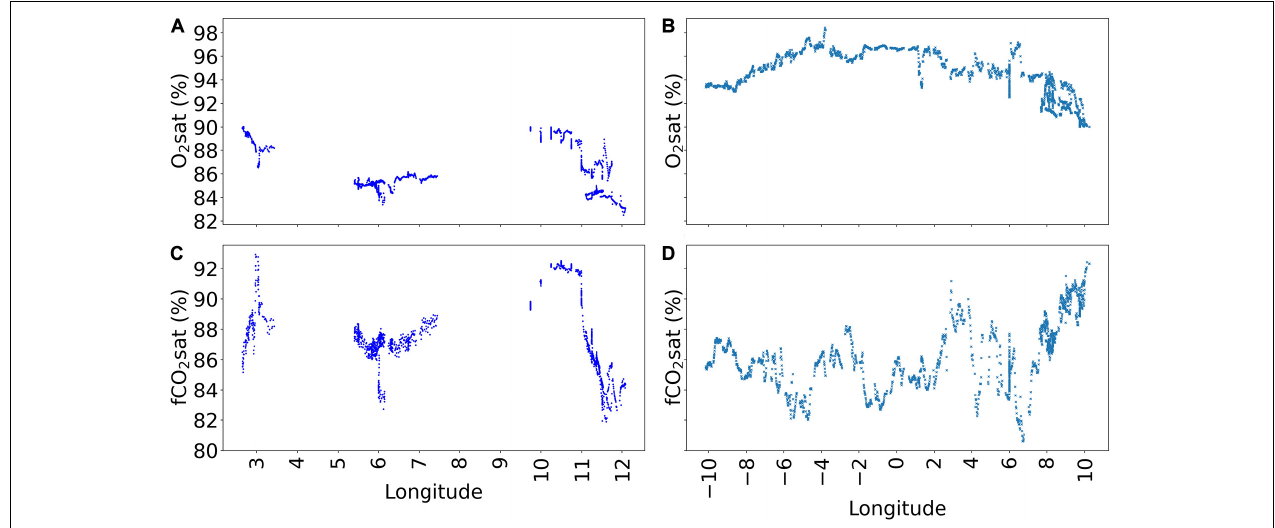
FIGURE 9 | Longitudinal distributions of the two data populations visualized in the QIV quadrant for the AR region in Figure 5B . (A,C) Distributions of O 2 sat and fCO 2 sat, respectively for the positive correlation data population. (B,D) Distributions of O 2 sat and fCO 2 sat, respectively for the negative correlation data